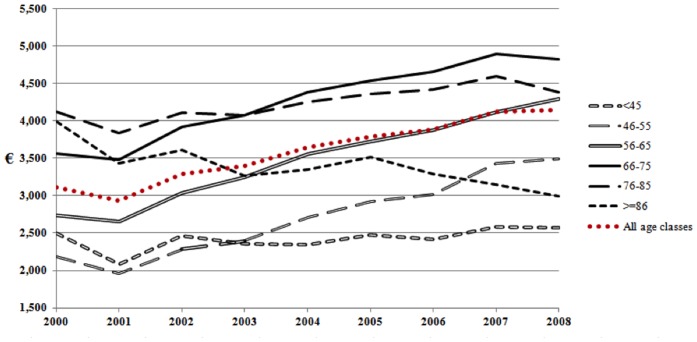
Men expenditure (€/patient-year) by age classes.